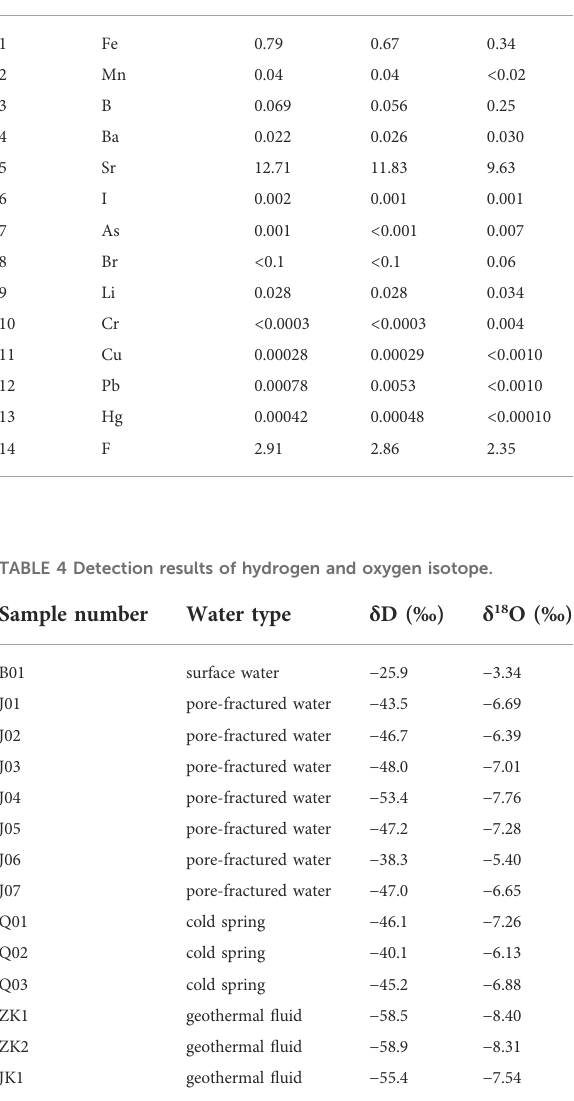
TABLE 3 Trace element content experiment data of geothermal fl uids (Unit: mg/L). Number Analysis item Well ZK1 Well ZK2 Well JK1